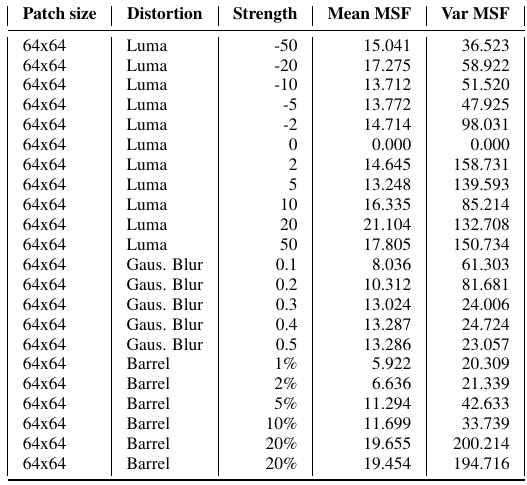
Table 1. Table of the analytic results of the test for each type of distortion Patch